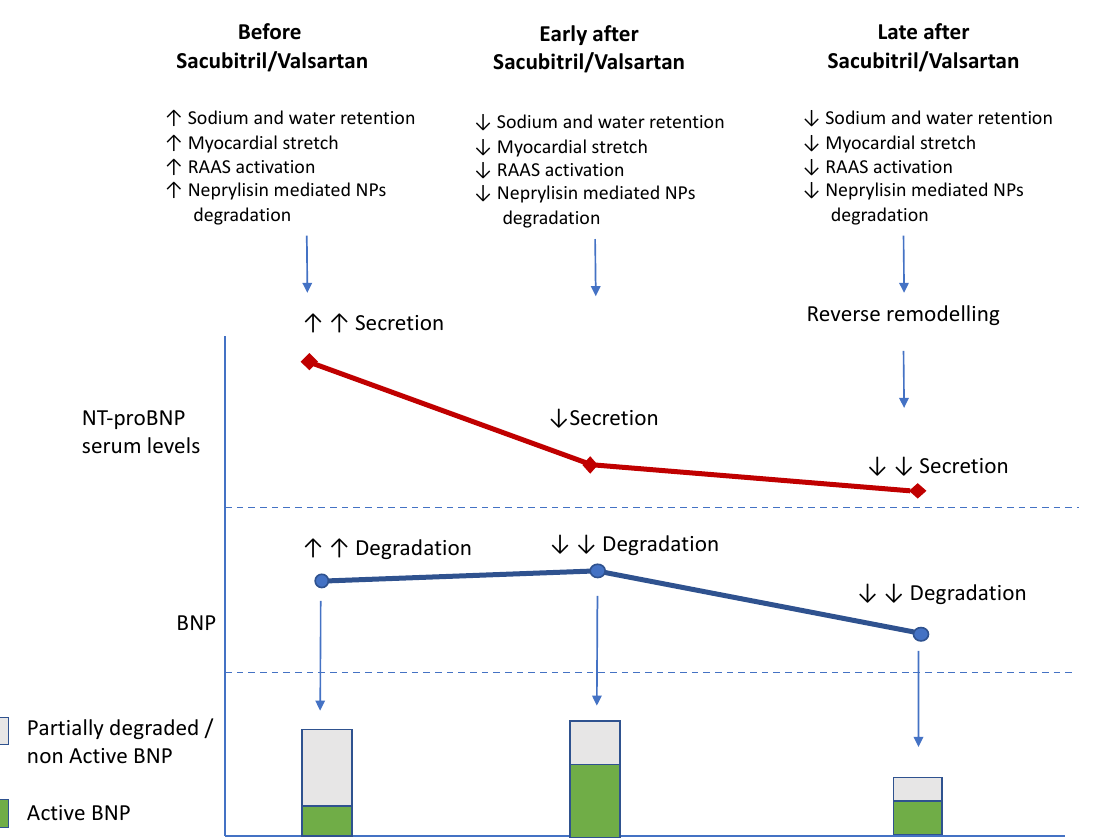
Figure 2. After sacubitril/valsartan administration, the inhibition of neprilysin leads to decreased degradation of BNP and to hemodynamic improvements. Consequently, it can be hypothesized that BNP serum levels increase and show a greater proportion of active hormones whereas NT-proBNP levels decrease. Late after the start of sacubitril/valsartan therapy, the hemodynamic improvement and the anti-remodeling effect lead to decreases in both BNP and NT-proBNP. Arrows indicates the increase ( ↑ ) or the decrease ( ↓ ) of the different mentioned effects. BNP: brain natriuretic peptide;